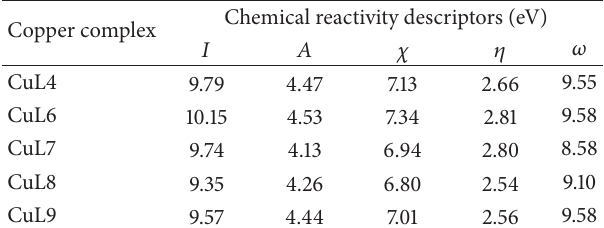
Table 3: Chemical reactivity parameters using DFT descriptors. Copper